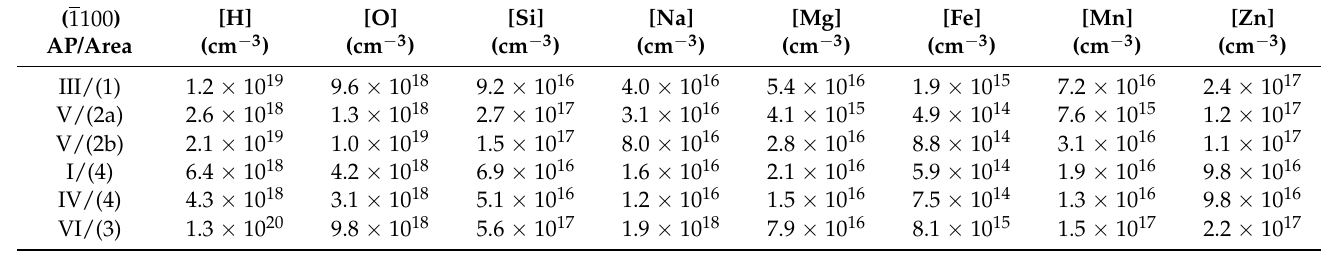
Table 2. Concentrations of the main impurities (donors and acceptors) measured using SIMS on the (cid:0) (cid:1) 1100 slice at six analysis points (APs) (indicated as Roman numerals in circles in Figure 3b) and the corresponding growth areas (indicated as Arabian numerals in brackets in Figure 3b).